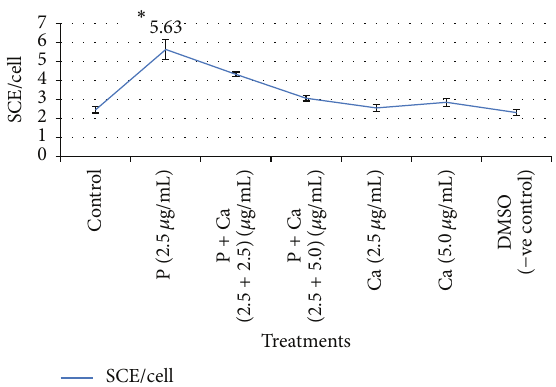
Figure 4: Ameliorative effect of carvacrol against parathion treated cultured human lymphocytes. ∗ 𝑃 < 0.05 (significance as compared to untreated), P: parathion, Ca: carvacrol, and DMSO: dimethyl sulphoxide.